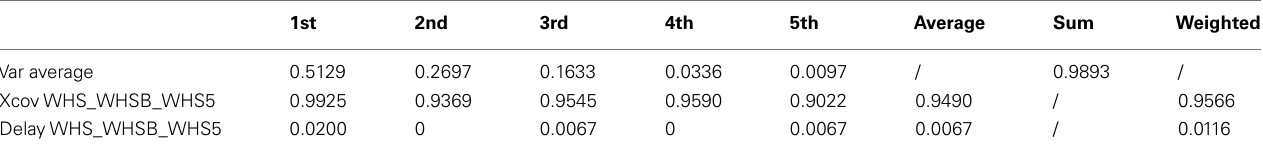
Table 5 |Walking with no constraint, holding an empty box and holding a 5 kg load kMPs (3